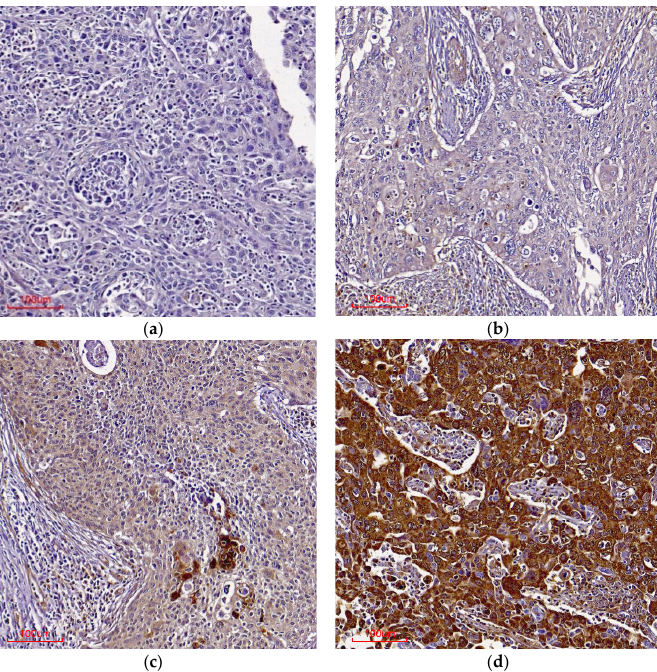
Figure 5. Immunohistochemical staining pattern in cervical tissue cores using CRNN antibody. ( a ) Absent staining in squamous cell carcinoma (SCC) cells. ( b ) Weak intensity cytoplasmic stain in SCC cells ( c ) Moderate intensity staining in the cytoplasm of SCC cells. ( d ) Strong intensity staining in the cytoplasm and membrane of SCC cells. Scale bar: 100 µ m, magnification: 100 ×